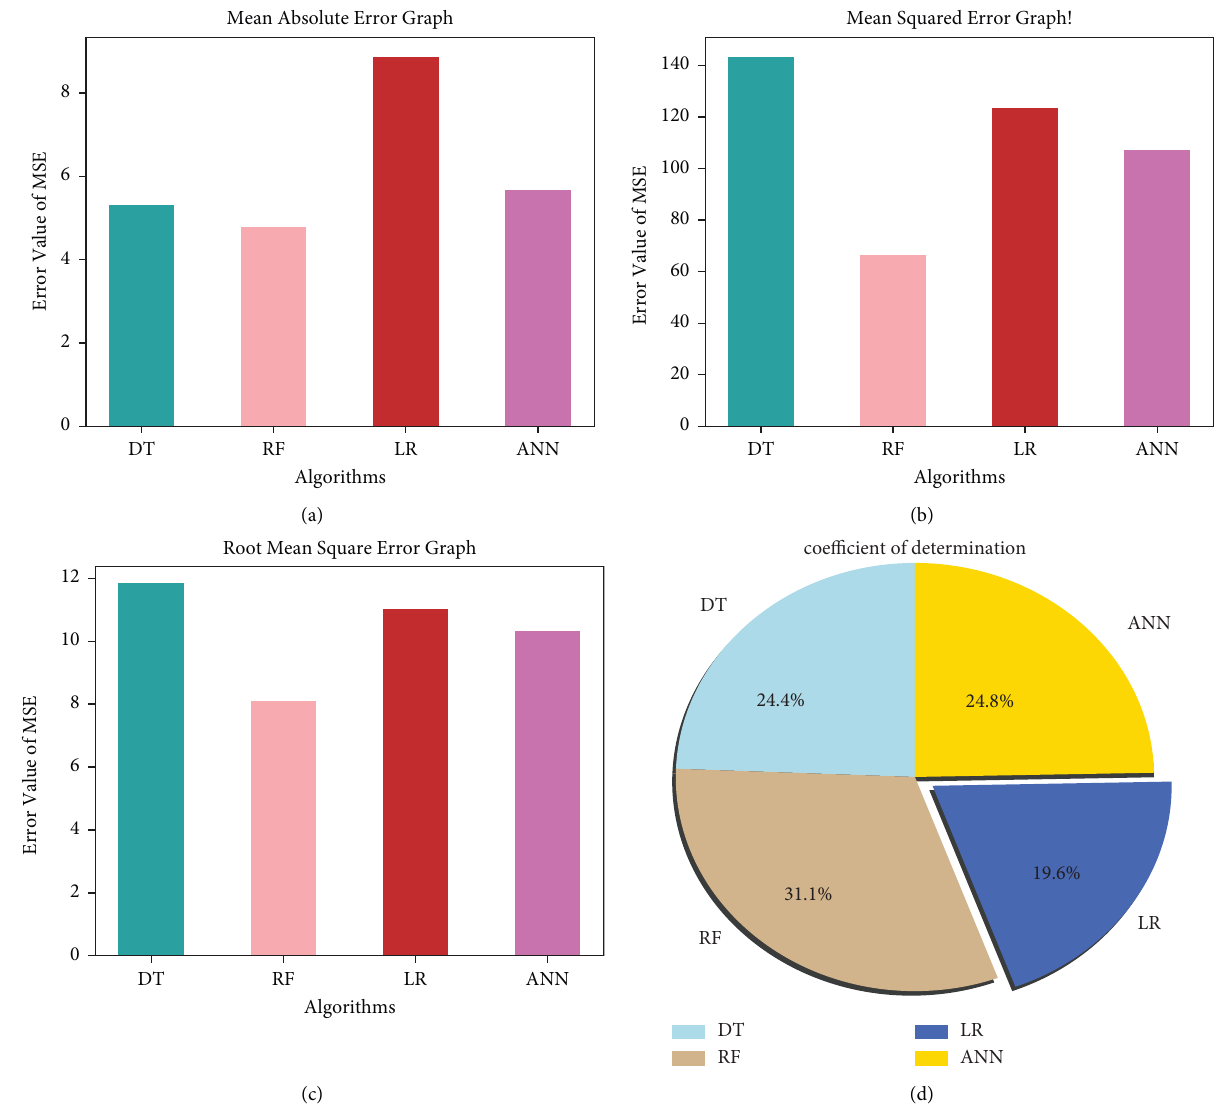
Figure 6: Comparison of the algorithms: (a) mean absolute error, (b) mean squared error, (c) root mean square error, and (d) coefcient of